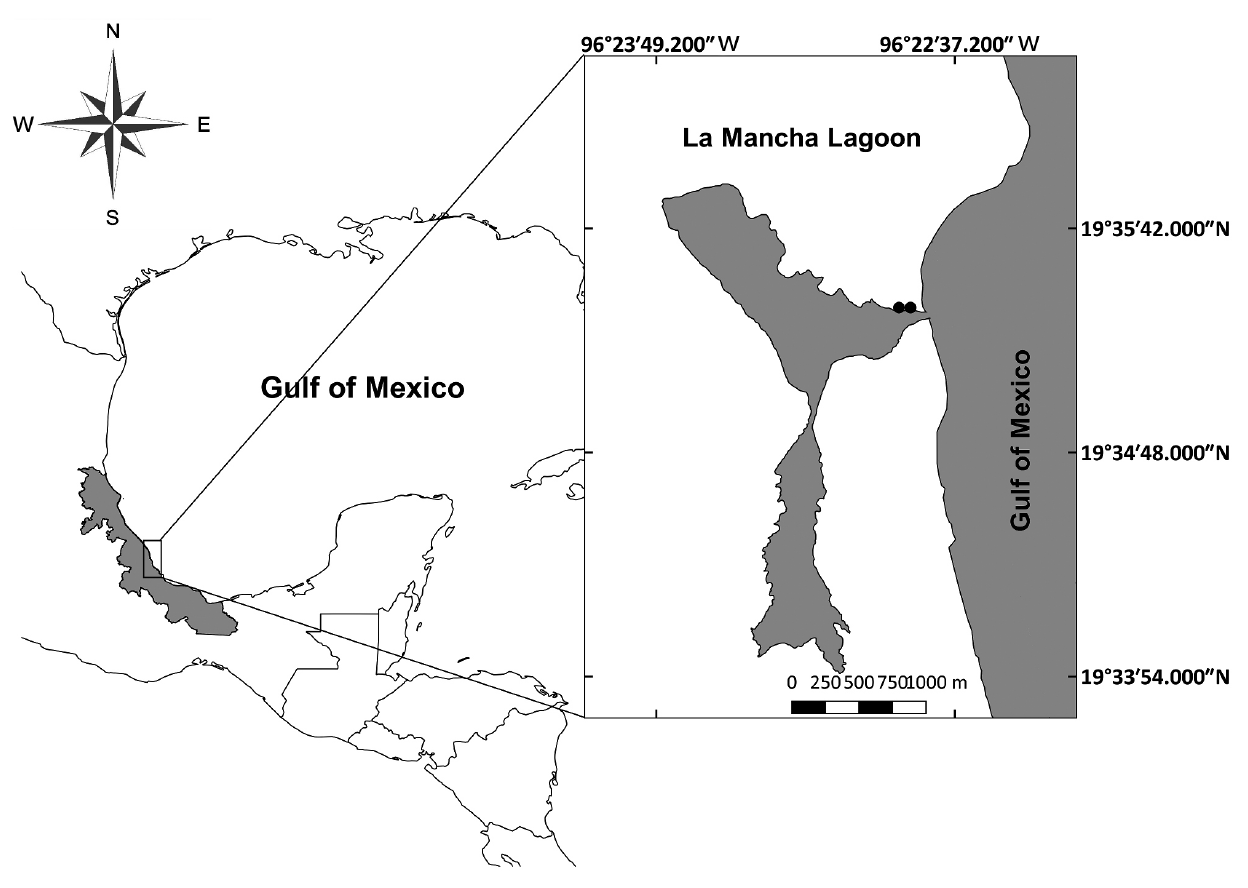
FIGURE 1 | Geographical location of La Mancha lagoon and sampling points (black